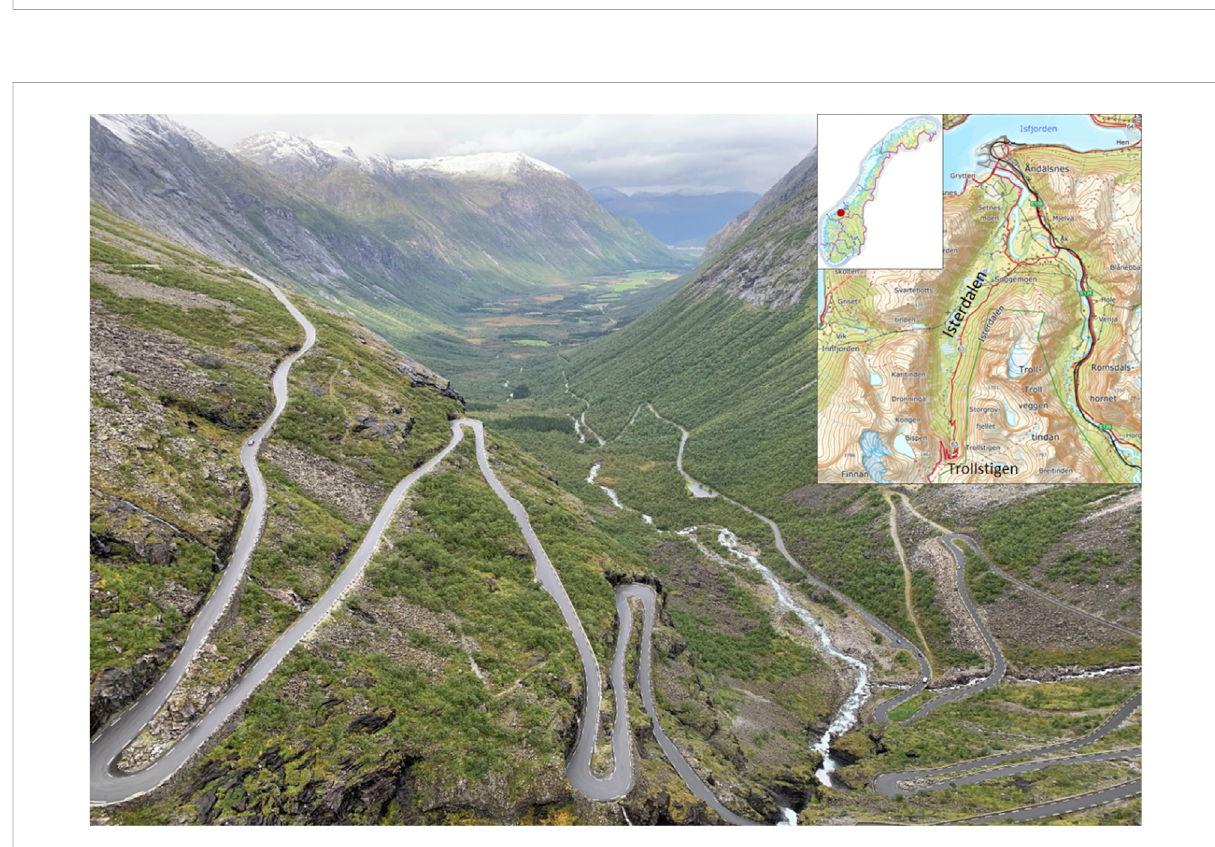
View of the road at Trollstigen and out the Isterdalen Valley (Photo: